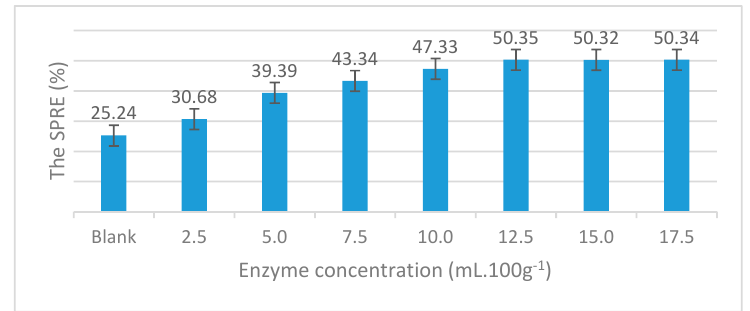
Figure 3. The e ff ect of enzyme content on the